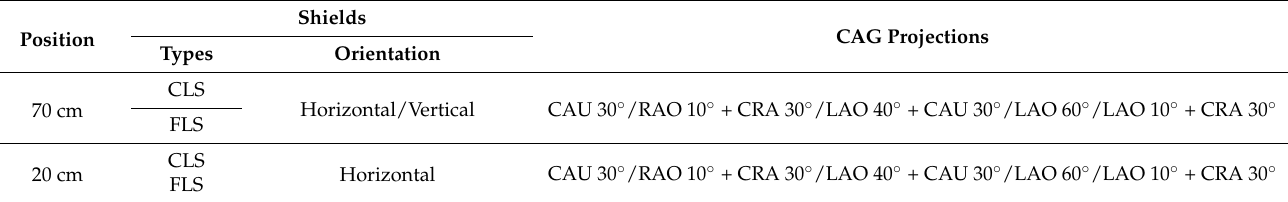
Figure 3. OSLD dosimetry system: ( A ) nanodot OSLDs; ( B ) microStar reader.